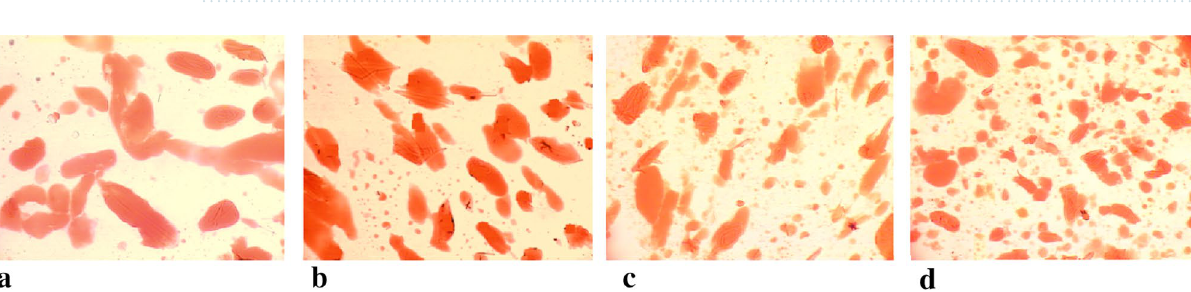
Figure 2. Microstructure of batter (x200) (fat globules) after 6 min chopping produced with varying rotational speed of chopper knives and bowl: ( a ) −1500/10 rpm −1 , ( b ) −1500/20 rpm −1 , ( c ) −3000/10 rpm −1 , ( d ) −3000/20 rpm −1 .